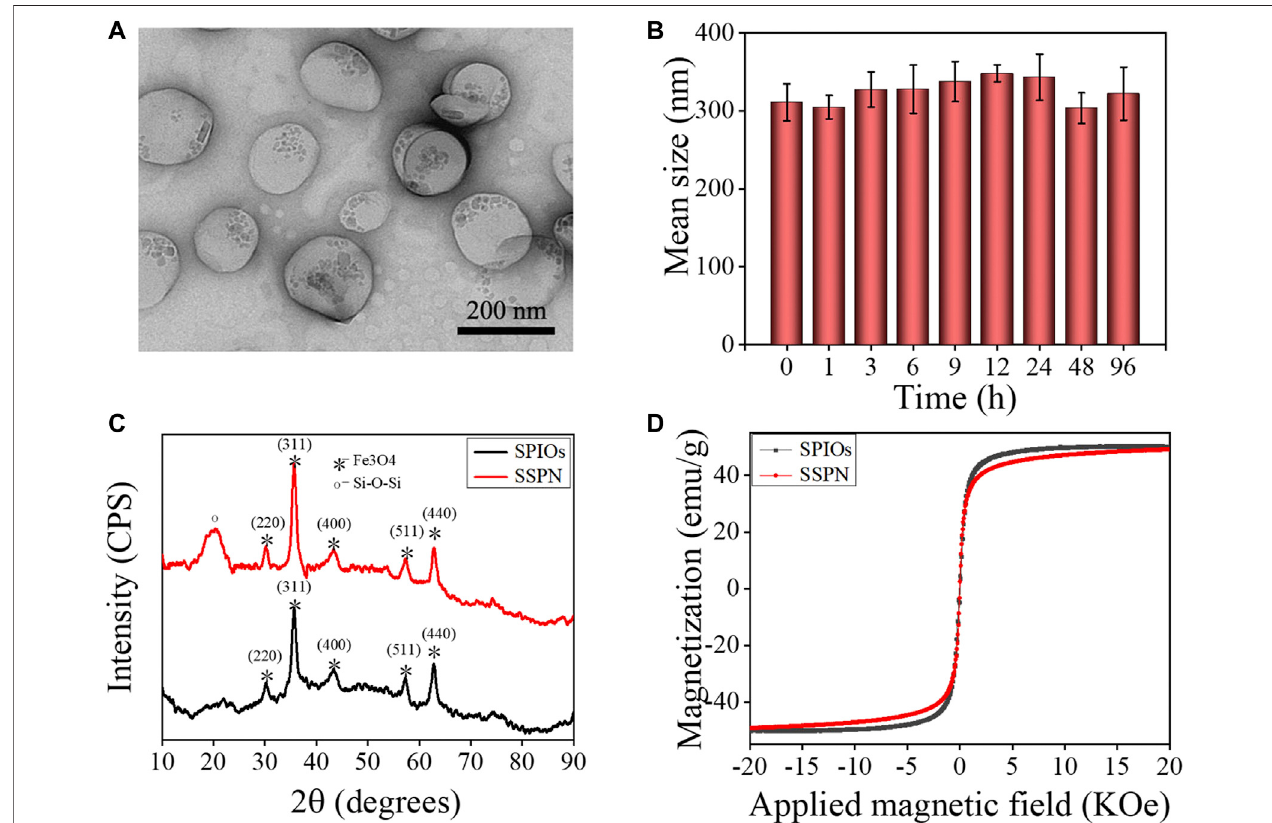
FIGURE2| CharacterizationsofSSPNs. (A) TEMimage.Scalebar=200 nm. (B) ThestabilityofSSPNsinPBScontaining10%FBSin96 h. (C) XRDspectrumsof SPIOs and SSPNs. (D) Magnetization curves of SPIOs and SSPNs.